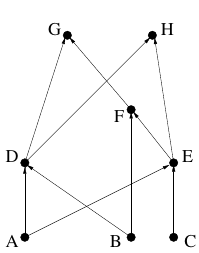
Figure 1. Both F and H are LCA for the 3-tuple A, B, C while G does not have this